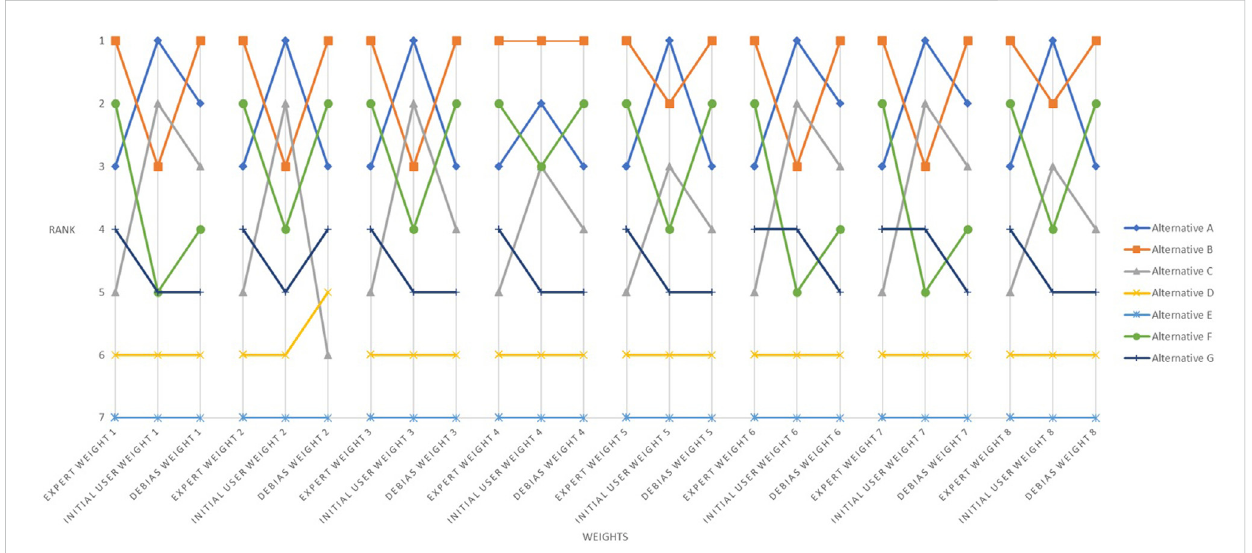
FIGURE 4 Sensitivityanalysis.ThesensitivityanalysisisbasedontherankingresultswhenapplyingthesimulatedinitialusercriteriaweightstotheAHPtooland then debiasing these